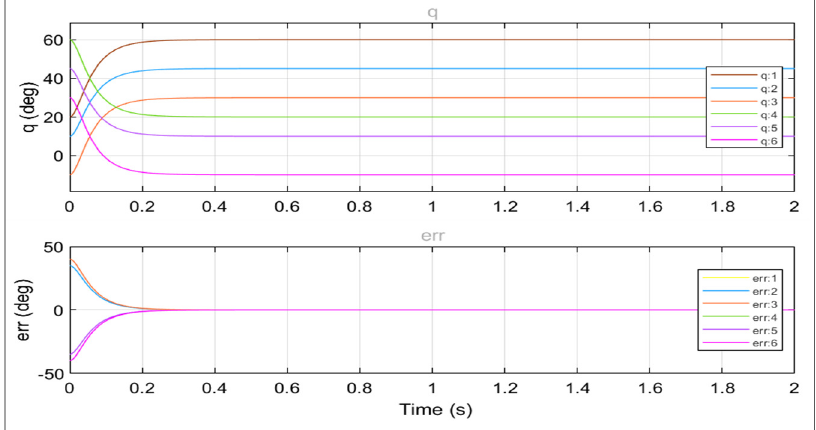
Fig. 8. Joints Trajectory of Step Input /Non-Linear Controller.